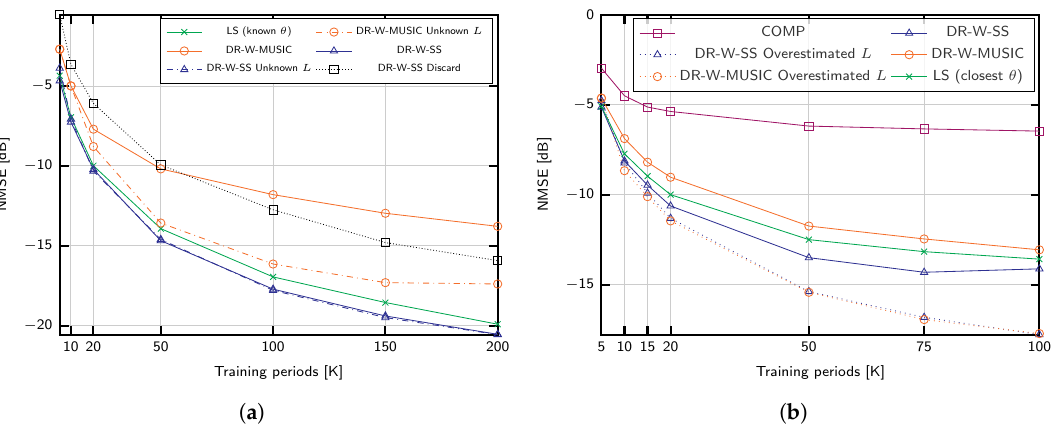
Figure 5. NMSE of covariance estimation for ( a ) M = 200 antennas, L = 15 propagation paths, T tr = 50, SNR = 0 dB, and subspace estimation; ( b ) M = 200, SNR = 0 dB, L = 5 propagation paths, and off-grid